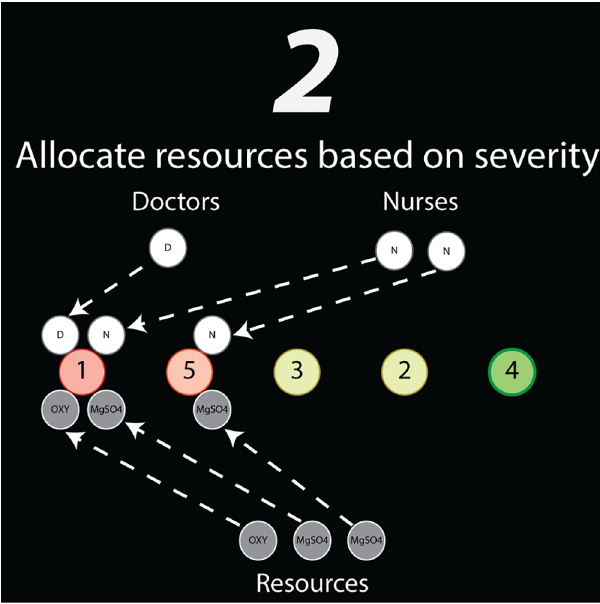
Fig 2. Schematic of the second step of the algorithm—allocation of resources to patients as prescribed by their respective treatment plans, starting with the patients with the highest probability of mortality (red) and ending with patients with the lowest probability of mortality